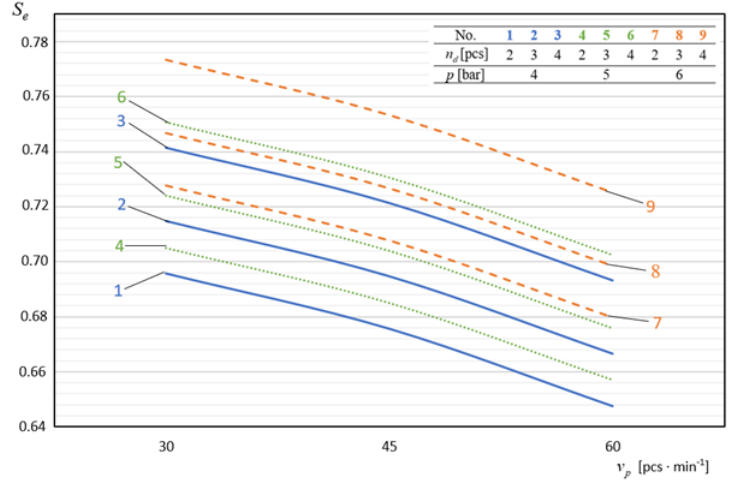
Figure 9. The influence of the material feed rate on shaping the effectiveness of the machine’s operation at constant parameters 𝑑 𝑛 = 1.5 mm and ℎ 𝑑 = 40 mm.